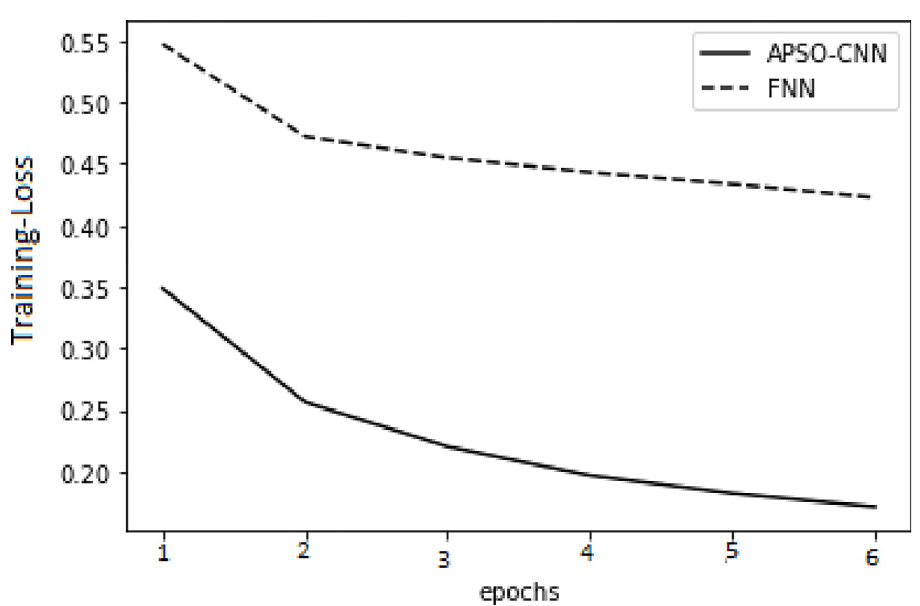
Fig 10. APSO–CNN and FNN algorithms’ loss function training sets.